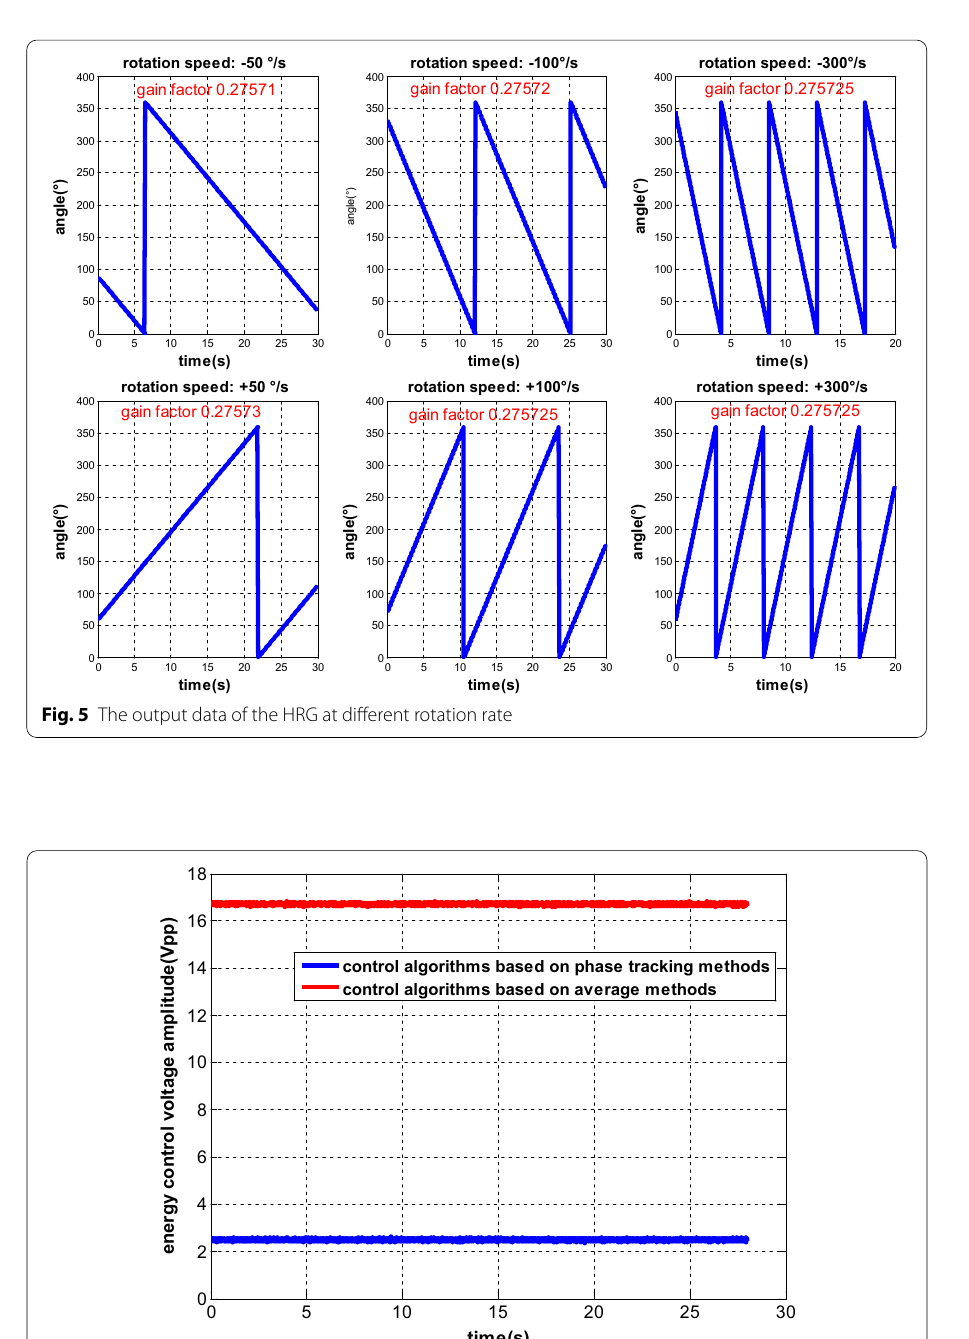
energy control voltages are recorded by upper-computer software, as shown in Fig. 6. Obviously, the phase tracking method in the paper, the energy control volt- ages could decrease an order of magnitude. It means that the energy transition effi- ciency increases by an order of magnitude.